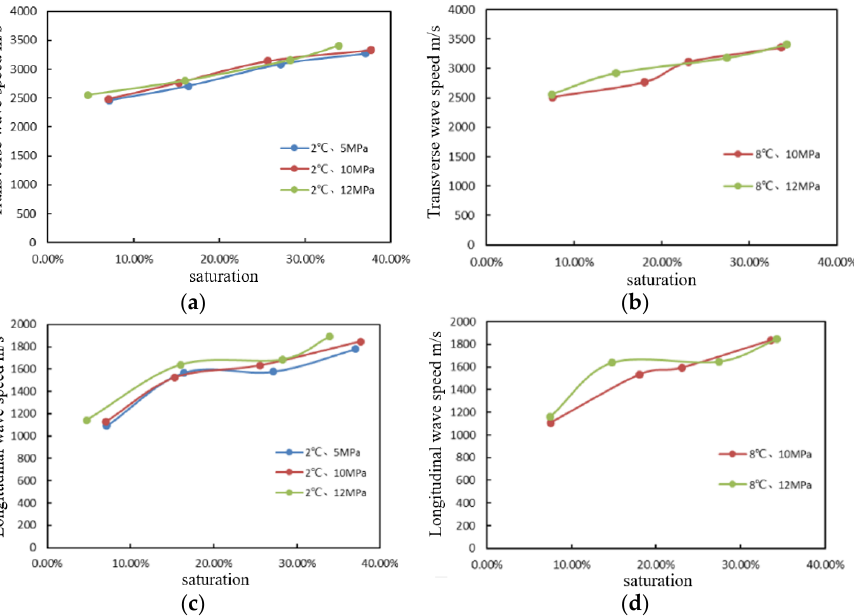
Figure 8. Variation of wave velocity with saturation ( a ) Transverse wave, temperature is 2 °C; ( b ) Transverse wave, temperature is 8 °C; ( c ) Longitudinal wave, temperature is 2 °C; ( d ) Longitudinal wave, temperature is 8 °C.